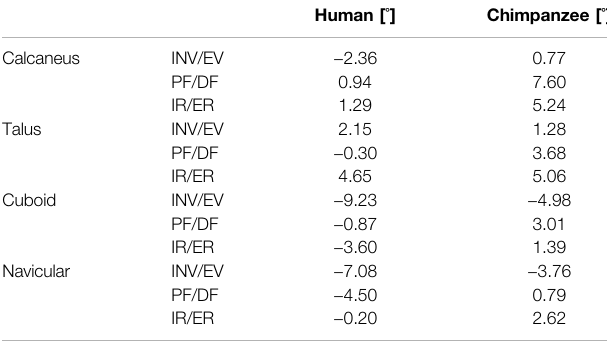
TABLE 2 | Angular displacements of foot tarsal bones (calcaneus, talus, cuboid, and navicular) during quiet standing of human and chimpanzee; positive values indicate inversion, plantar fl exion, internal rotations.